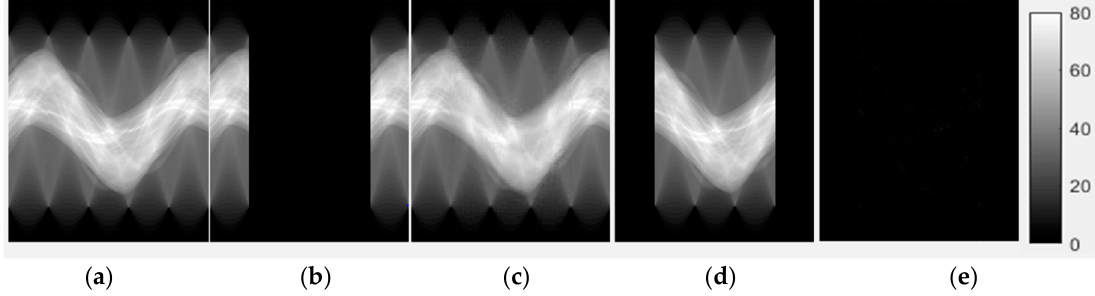
Figure 5. Evaluation of the completed LA sinogram results from the sinograms and their reconstructed images. ( a ) True sinogram, ( b ) Simulated LA sinogram and ( c ) CE inpainted sinogram from the testing set. ( d ) The difference of the sinogram ( a ) subtracted by ( b ) and ( e ) is the difference of the sinogram ( a ) subtracted by ( a ) and ( c ).